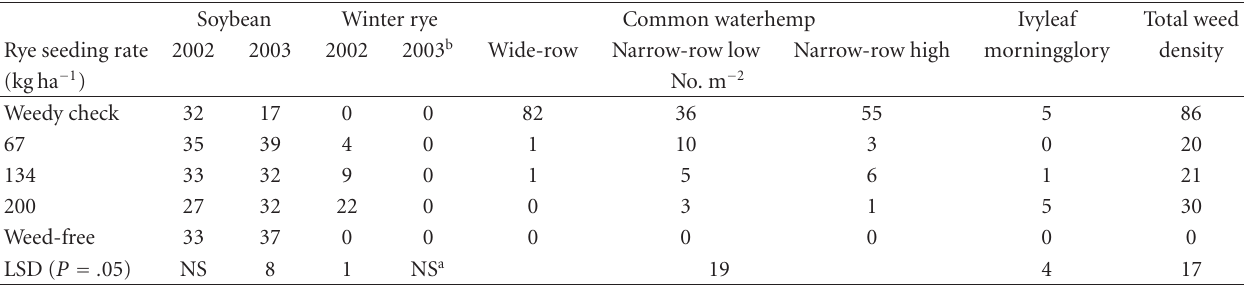
Table 3: E ff ect of winter rye seeding rate on soybean, winter rye, common waterhemp, ivyleaf morningglory, and total weed density in 2002 and 2003. Data were combined over years and row spacings unless denoted otherwise.